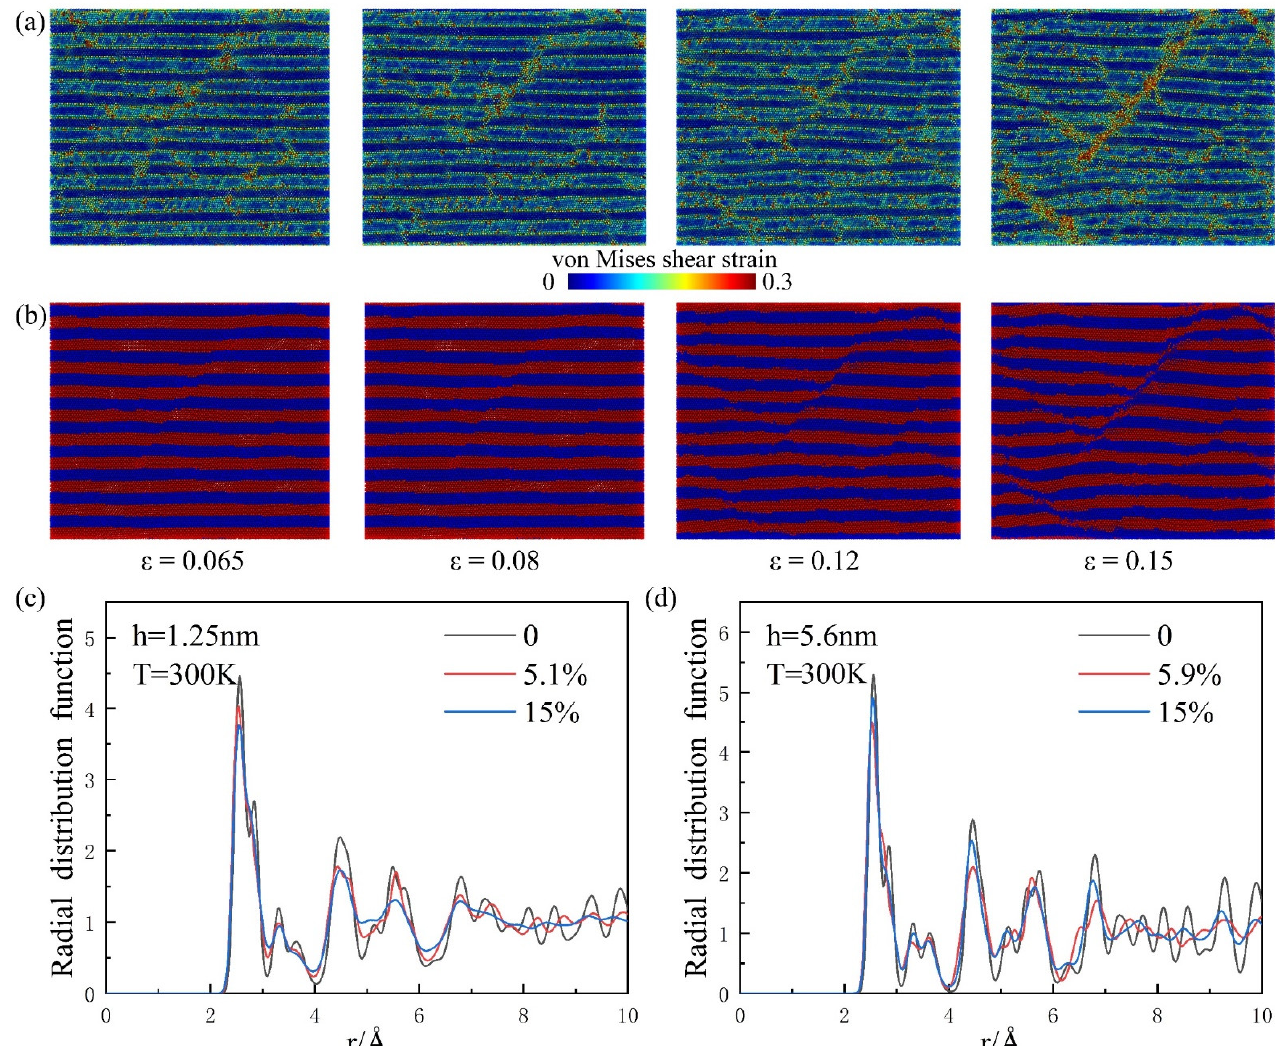
Figure 7. Snapshots of ( a ) von Mises shear strain distribution and ( b ) atomic configuration of h =1.25 nm samples at different strain values. The radial distribution function for ( c ) h = 1.25 nm and ( d ) h = 5.6 nm samples at 300 K.